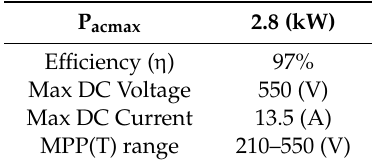
Table 2. Main characteristics of the